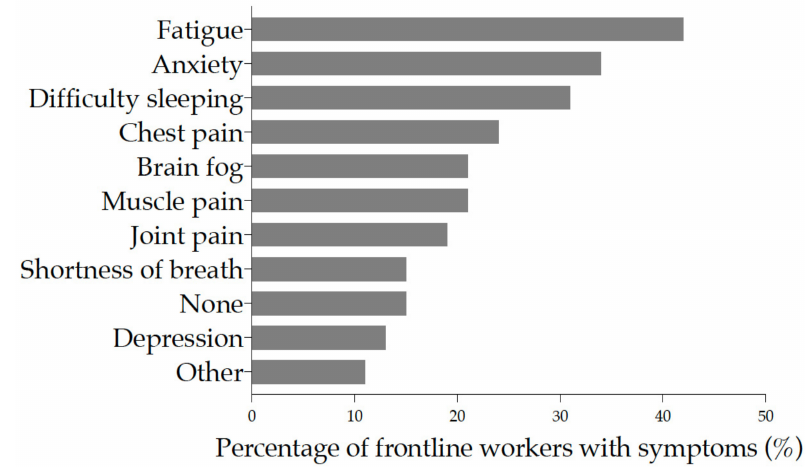
Figure 5. Reported post-acute COVID-19 symptoms among frontline workers. Each symptom is ordered from top to bottom by increasing frequency of occurrence. The bars represent the proportion of workers with symptoms.